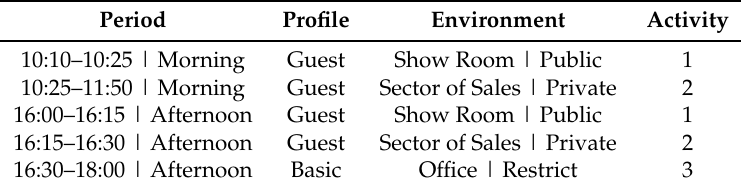
Table 11. Customer user